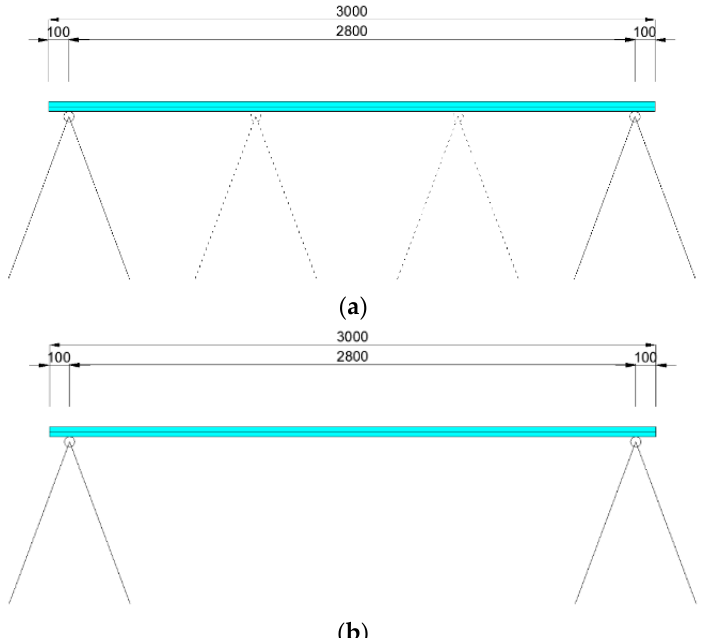
Figure 6. Static scheme of the laminated glass: ( a ) during the mount, ( b ) during the